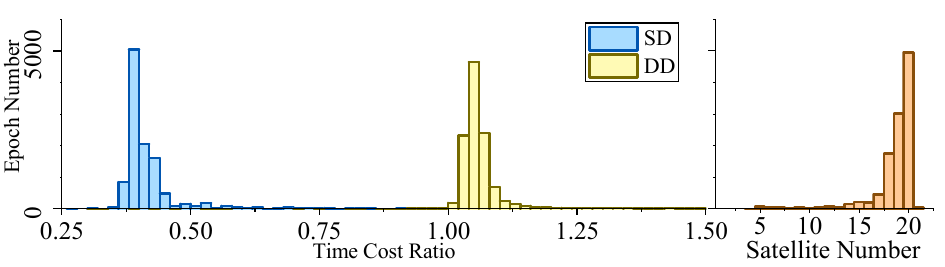
Figure 7. Time–cost ratio and satellite number histogram of dataset 3.